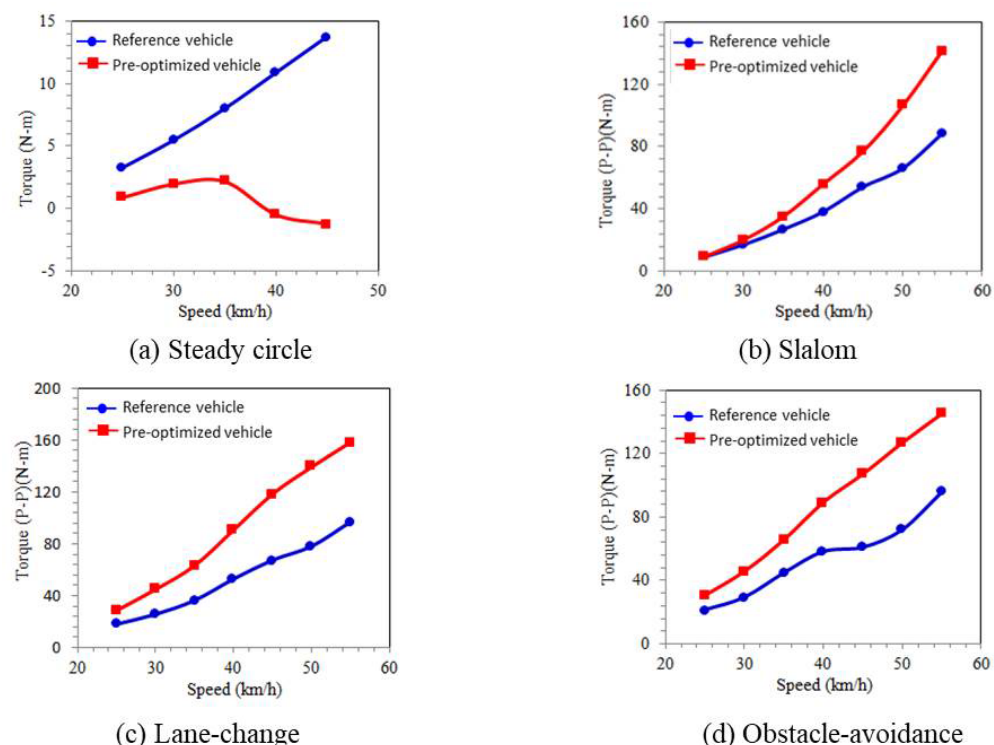
Figure 18. Simulation results of steering